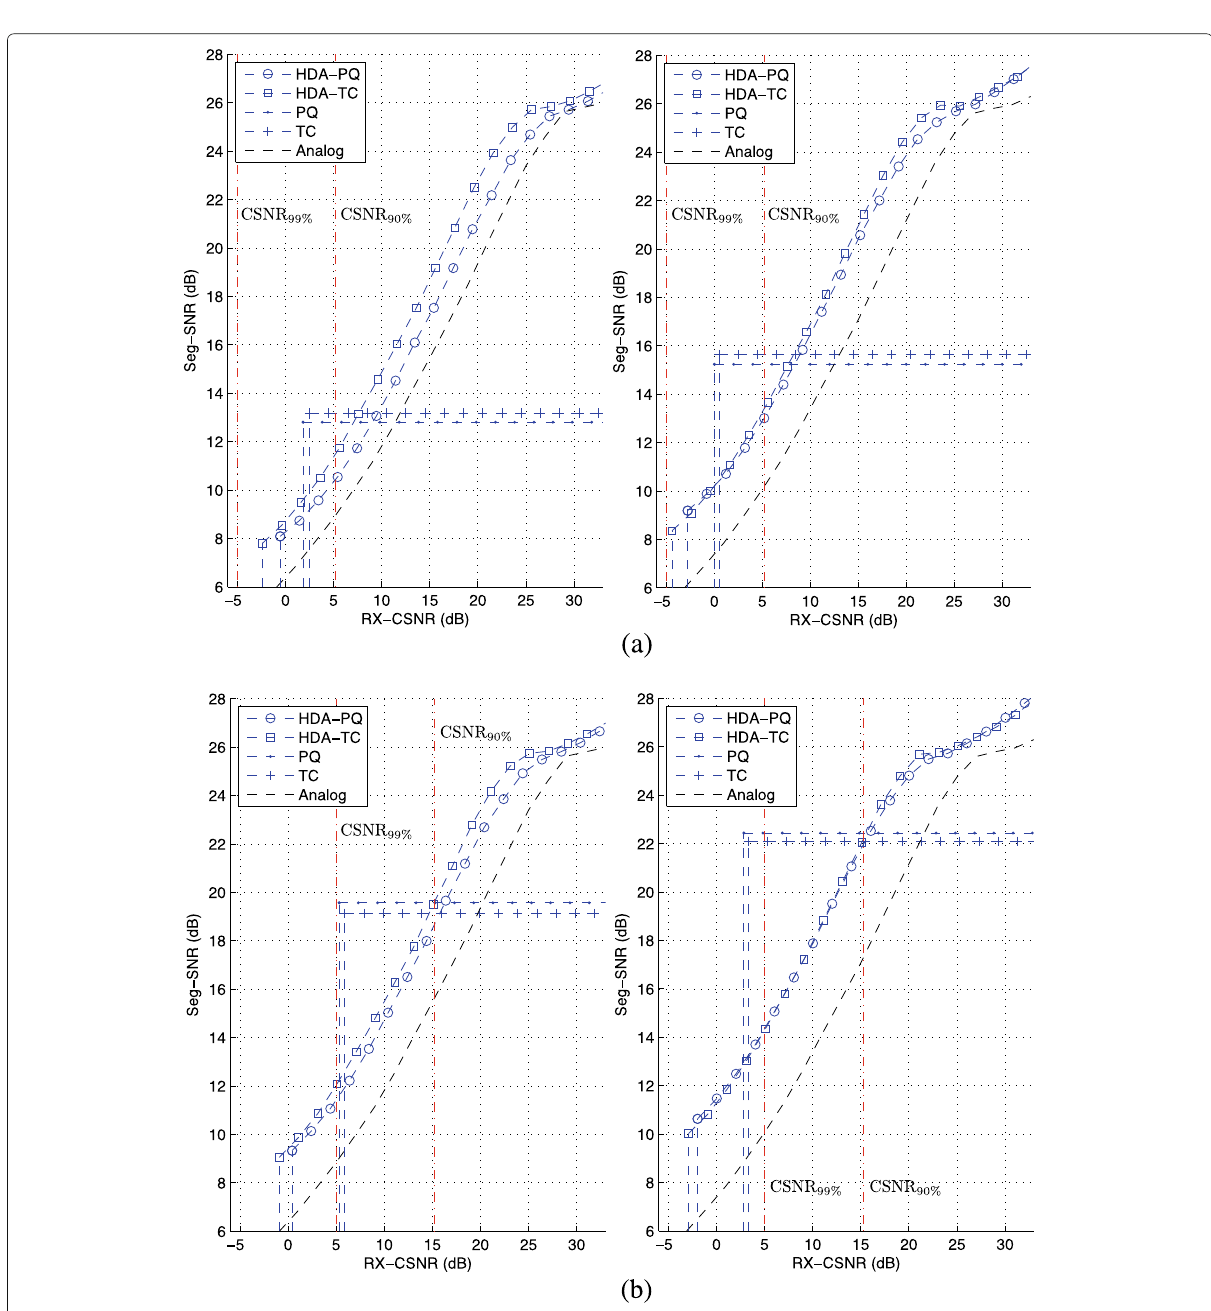
Fig. 7 Experimental seg-SNR of speech test set 2 on channels with different mean CSNRs. Both HDA-PQ prediction order and HDA-TQ transform block size are 10. a ¯ θ = 15, left : b = 3, right : b = 5. b ¯ θ = 25, left : b = 3, right : b =